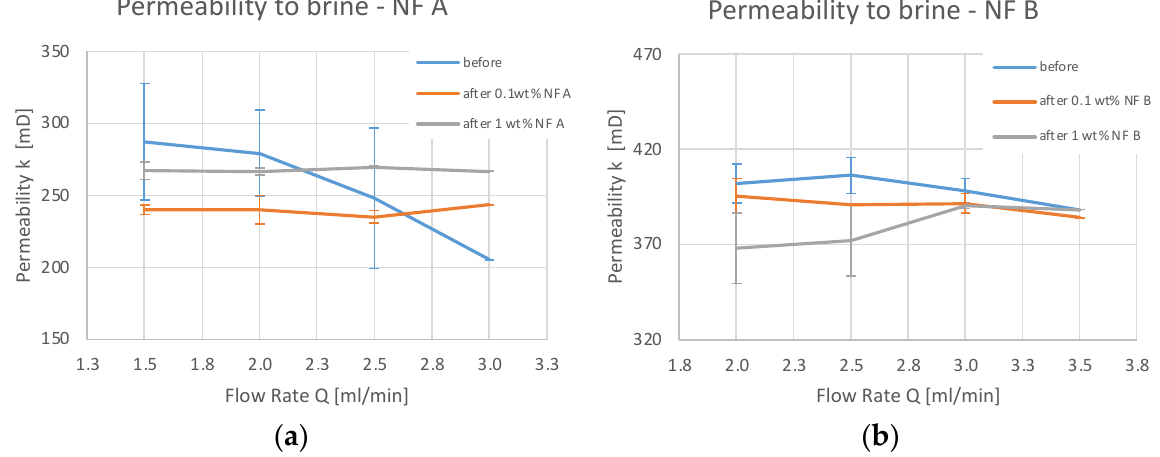
Figure 6. Permeability to brine was measured before a nanofluid injection (blue), after an injection of 0.1 wt% of NF (orange) and after an injection of 1 wt% NF (grey). NF A ( a ) and NF B ( b ) were both diluted in TW, and all permeability measurements were conducted with TW.